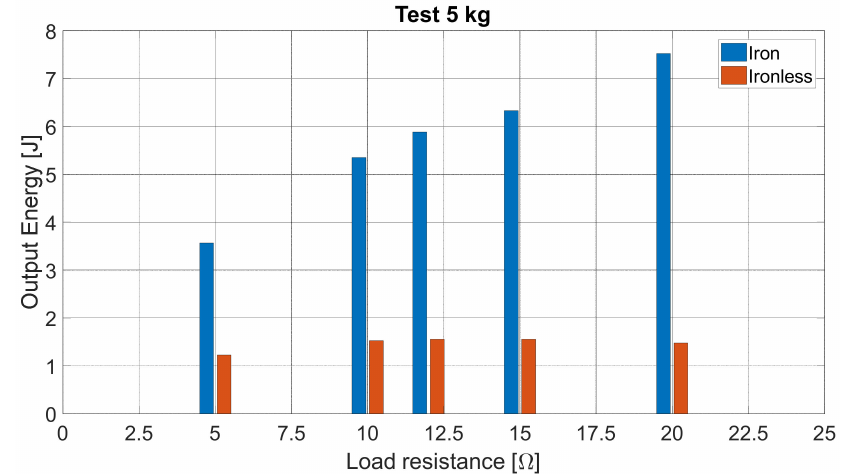
Figure 19. Energy transferred to the electric loads at 5 kg by the two PMLG prototypes.